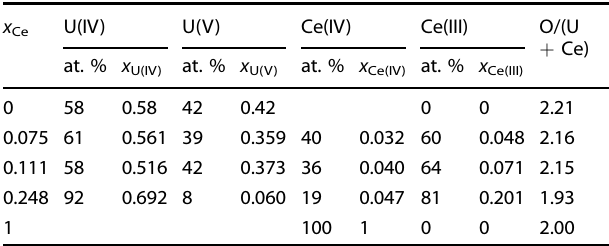
Atomic fractions of U(IV) and U(V) with respect to U tot . Atomic fractions of Ce(III) and Ce(IV) with respect to Ce tot . Corresponding stoichiometries in the solid